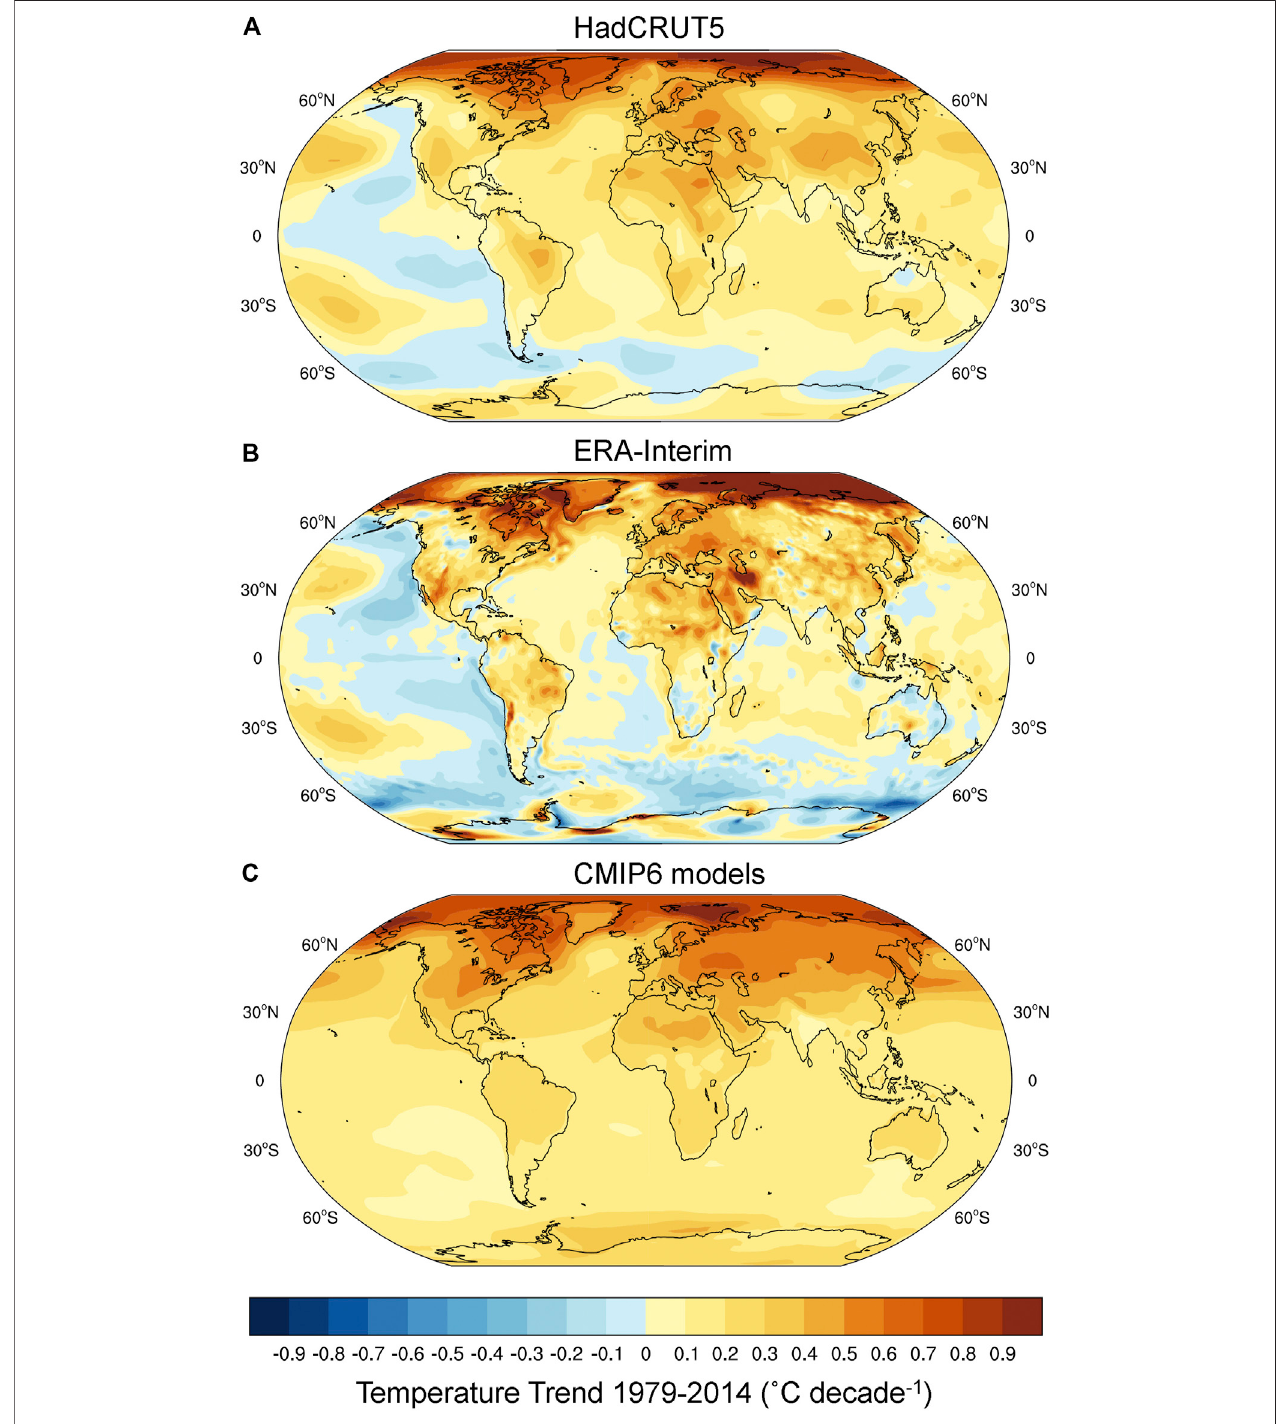
FIGURE1| Annual-meannear-surfacetemperaturetrends( ˚ Cdecade − 1 )for1979 – 2014from (A) HadCRUT5observations, (B) theERA-Interimreanalysis,and (C) the historical CMIP6 multimodel